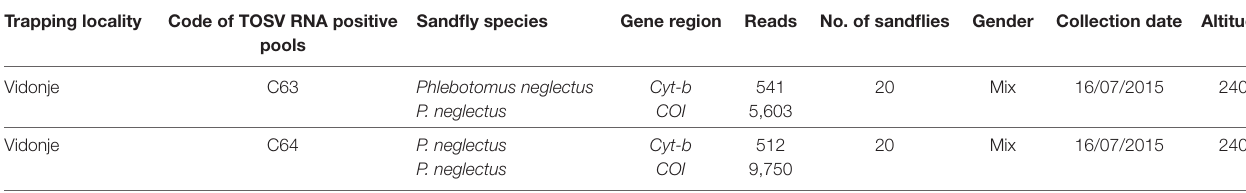
tabLe 2 | Toscana virus (TOSV) positive pools information. trapping